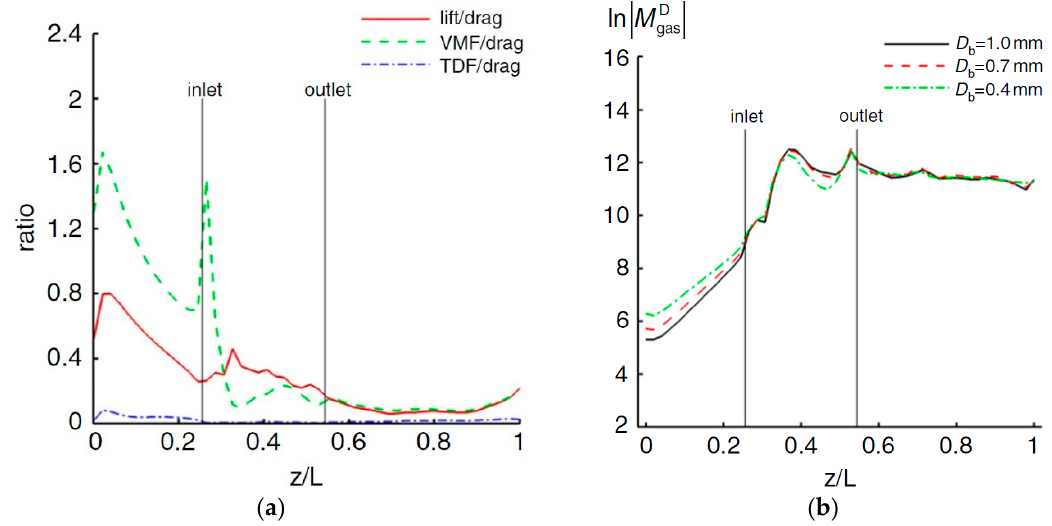
Figure 15. Magnitude analysis of interface forces by CFD simulations [112], ( a ) magnitude ratios of non-drag forces to drag force; ( b ) bubble size effect on drag force magnitude.